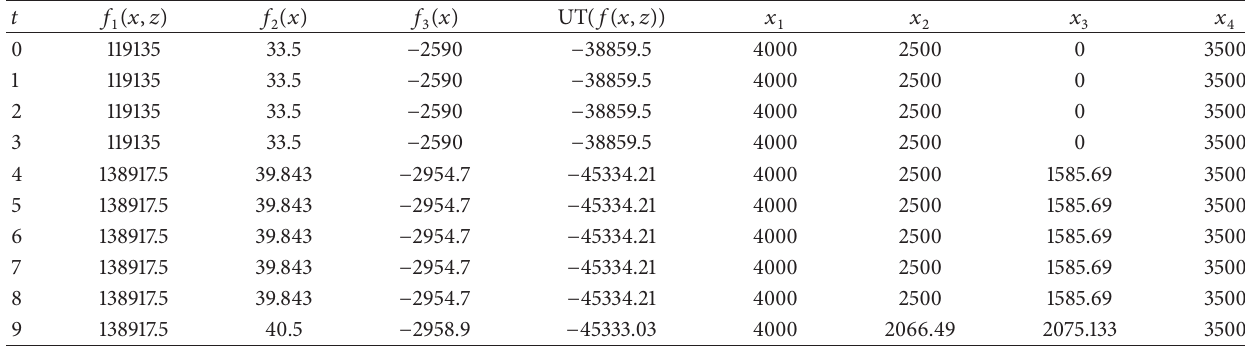
Table 2: The solutions of the subproblems according to different values of 𝑡 .